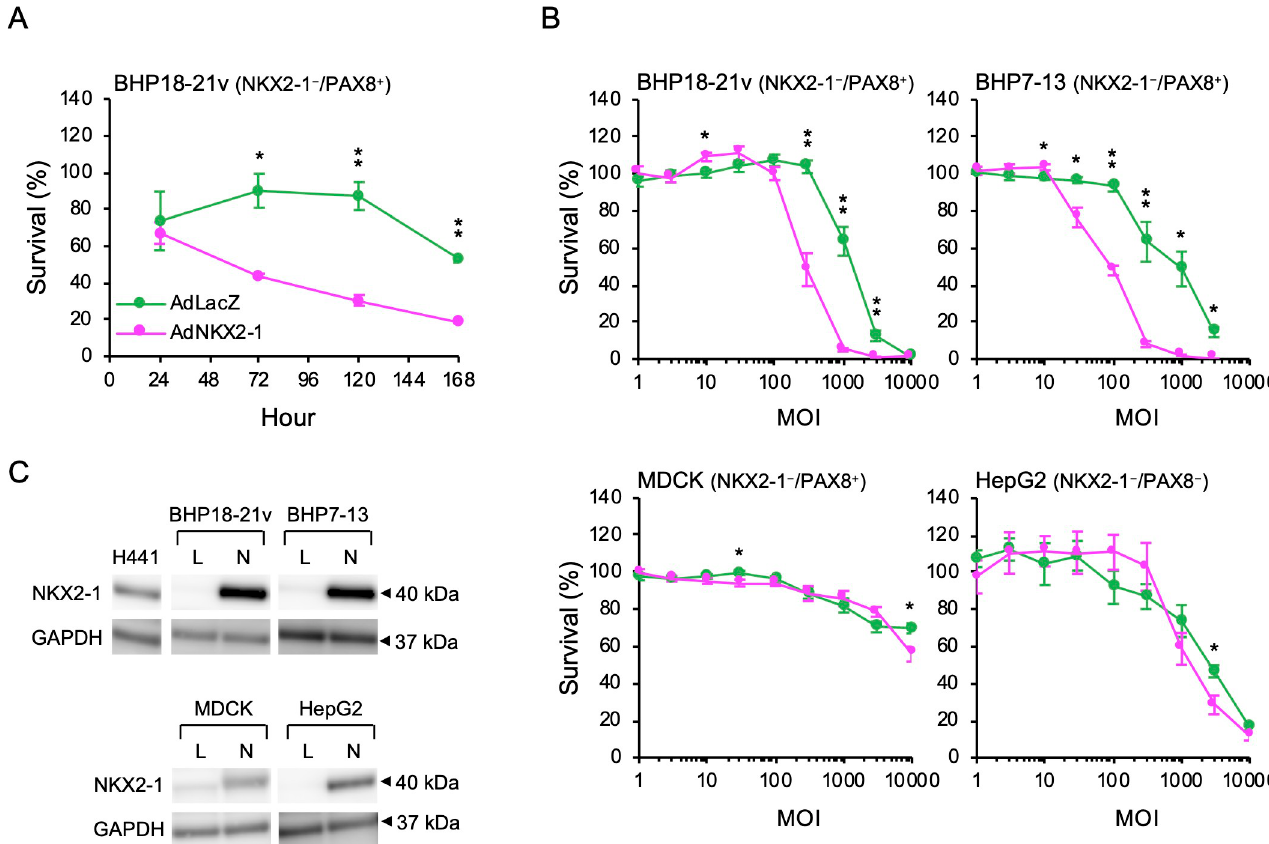
Fig 1. Cell viability after AdNKX2-1 and AdLacZ infection. (A) Time-dependent changes after 1000 MOI adenoviral vectors infection in BHP18-21v cells (n = 9). (B) MOI-dependent changes 120 h after adenoviral vector infection (n = 4–9). The ratios of surviving infected cells to non-infected cells at the same timepoint after infection are shown. Error bars indicate SEM. � p < 0.05 and �� p < 0.01, significant differences between AdNKX2-1 and AdLacZ. (C) Western blots showing NKX2-1 expression 72 h after infection with 300 MOI AdLacZ or AdNKX2-1 (upper panel). Loading control, GAPDH expression (bottom panel). L, AdLacZ; N,